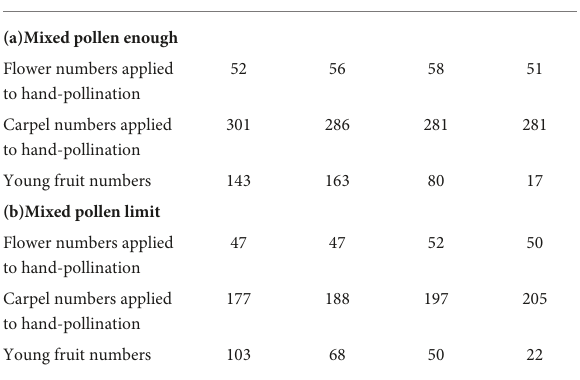
TABLE 2 Results of two-way analysis of variance of a complete factorial test for the effect of deposition of different ratios of cross- and self-pollen, carpel numbers, and total pollen numbers on young fruit